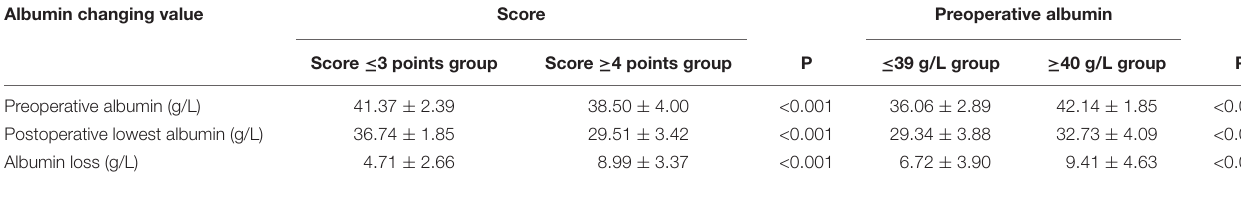
TABLE 6 | Comparison of perioperative albumin changing value divided by scoring scale and preoperative albumin value.